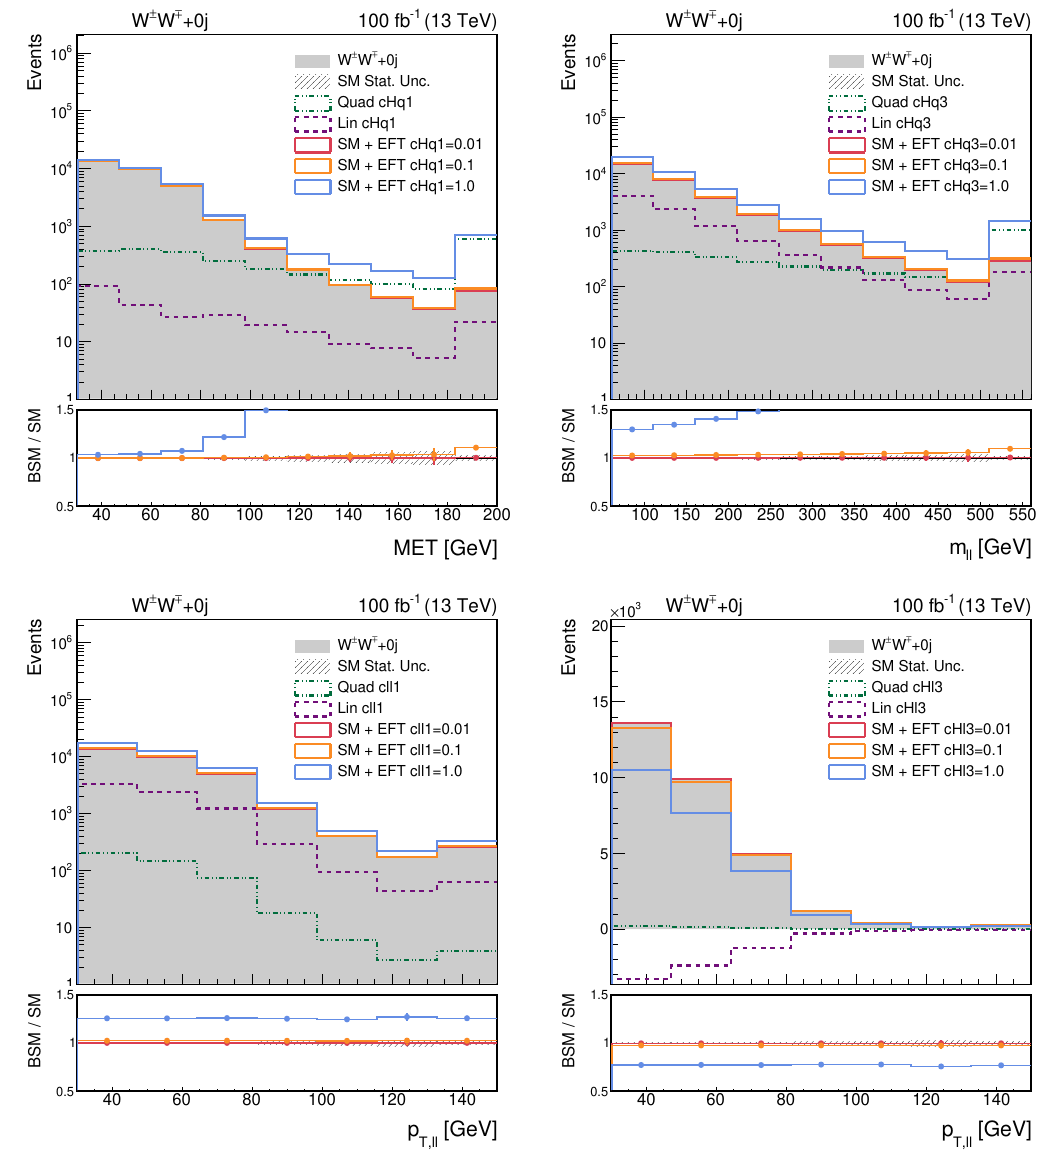
Figure 11 . Comparison of SM (filled histograms) and BSM (lines) expected number of events after the event selection in table 4, for various observables and Wilson coefficients in the inclusive WW process, at an integrated luminosity of 100 fb − 1 . Solid lines show the total prediction for one Wilson coefficient at a time, with c Λ 2 = 0 . 01 (red), 0 . 1 (orange) or 1 TeV − 2 (blue). The pure interference α / (quadratic) EFT component, normalized to c Λ 2 = 1 TeV − 2 , is indicated with a purple (green) α / dashed line. For all distributions, the last bin comprises all the overflow